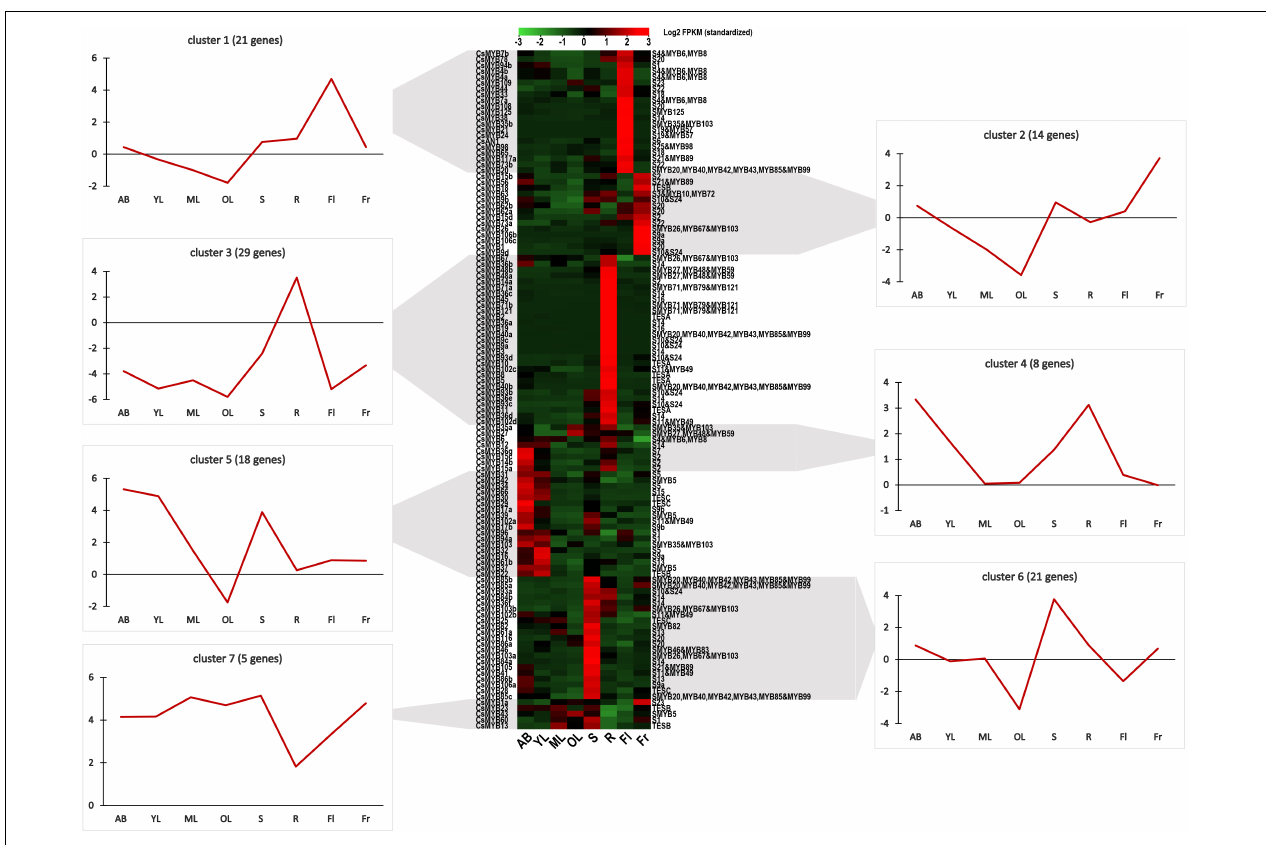
FIGURE 2 | Heatmap of the 118 CsR2R3-MYB genes transcribed in the tissues of C. sinensis . The 118 CsR2R3-MYB genes clustered into seven expression groups, based on their tissue-specific expression. The gene name is indicated on the left of the heatmap, and the short name of the phylogenetic subgroup is on the right. Transcript abundance is expressed in standardized log2 fragments per kilobase of exon per million fragments mapped (FPKM) values. Next to each RNA-seq-based cluster, there is a graph with the mean transcript abundance for the entire cluster in each tissue. AB, apical bud; YL, young leaf; ML, mature leaf; OL, old leaf; S, stem; R, root; Fl, flower; Fr, fruit. Data were obtained from the Tea Plant Information Archive (http://tpia.teaplant.org/).